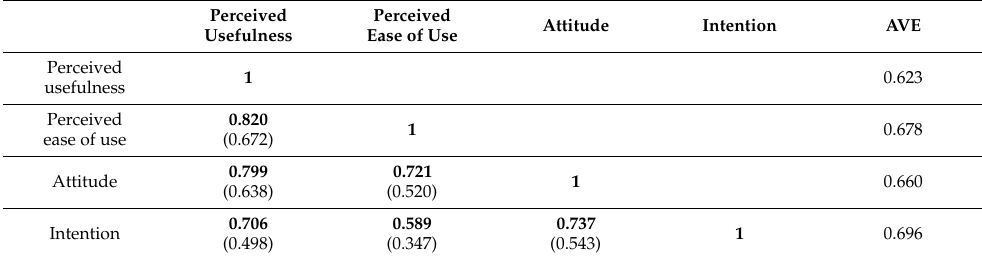
Table 3. Summary of discriminant